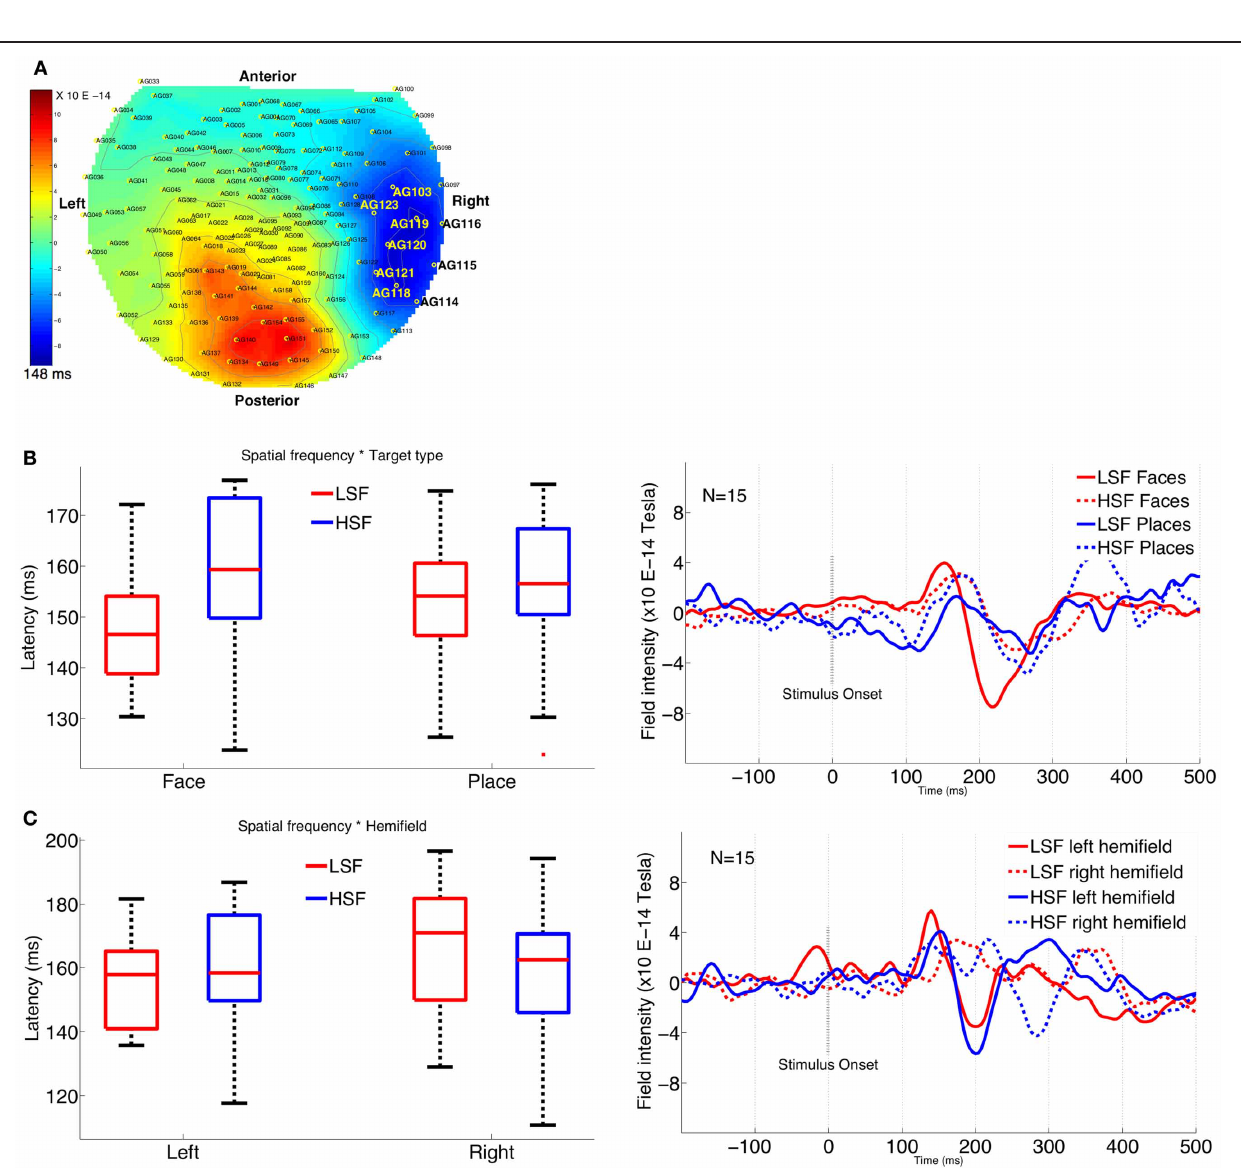
FIGURE 4 | Plots showing M170 latency across various conditions. (A) Topographical display of the MEG sensors, shows the cluster of right occipito-temporal sensors selected for latency analysis. (B) Interaction graph and plot (from the sensor 121) shows significant